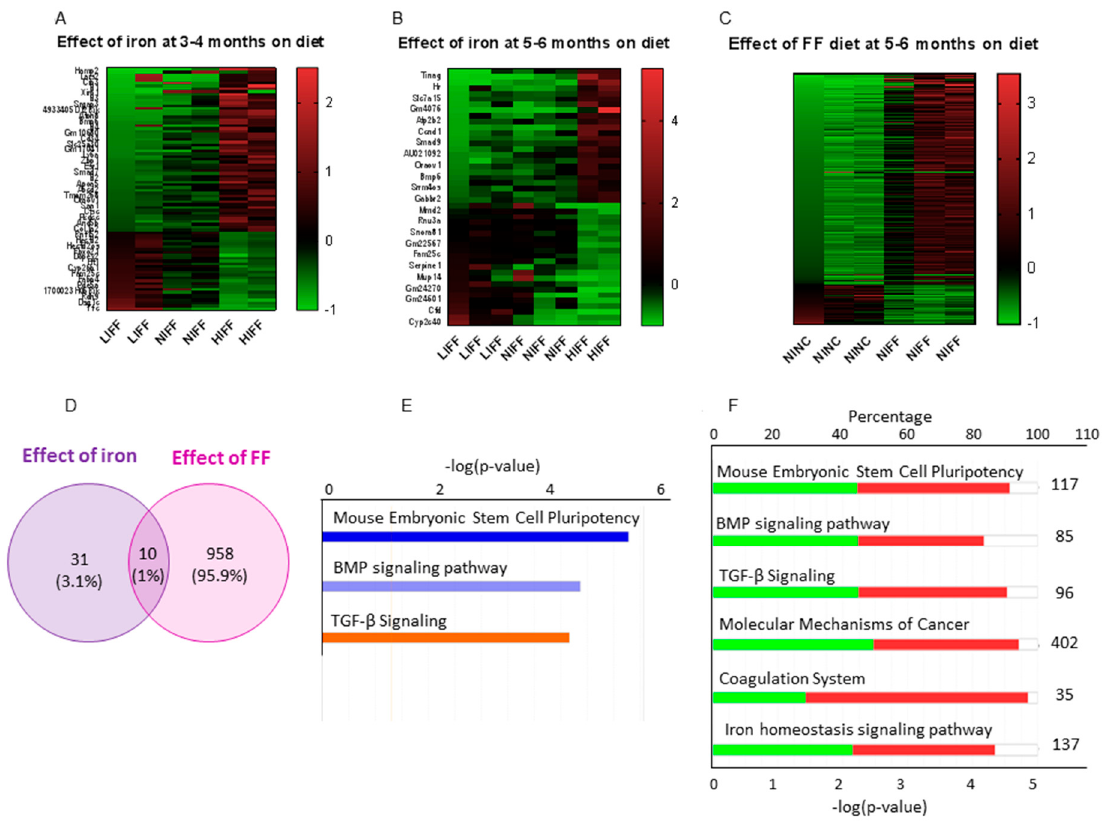
Figure 5. Differential gene expression in the hepatic transcriptome induced by iron and FF: ( A – C ) Heat maps of DEG using cutoff log2FC >1 or < − 1, p < 0.01 on DeSEq2 data. Each row represents a DEG and each column is a sample from an individual mouse fed the diet as indicated by the column label. ( A ) Effect of iron in the FF-fed mice at 3–4 months. First two columns: low iron (LI) FF; next two columns: normal iron (NI) FF; last two columns: high iron (HI) FF. ( B ) Effect of iron in the FF-fed mice at 5–6 months; three samples each for LIFF and NIFF and two samples for HIFF. ( C ) Effect of FF compared to normal chow (NC). First three columns: LINC; next three columns: LIFF. ( D ) Venn diagram of DEGs affected by iron and FF, showing only 1% of genes altered by both iron and FF. ( E ) Bar chart of top 3 canonical pathways enriched by IPA core analysis. ( F ) Stacked bar chart of the number of genes upregulated and downregulated in the top 6 canonical pathways enriched by IPA core analysis.